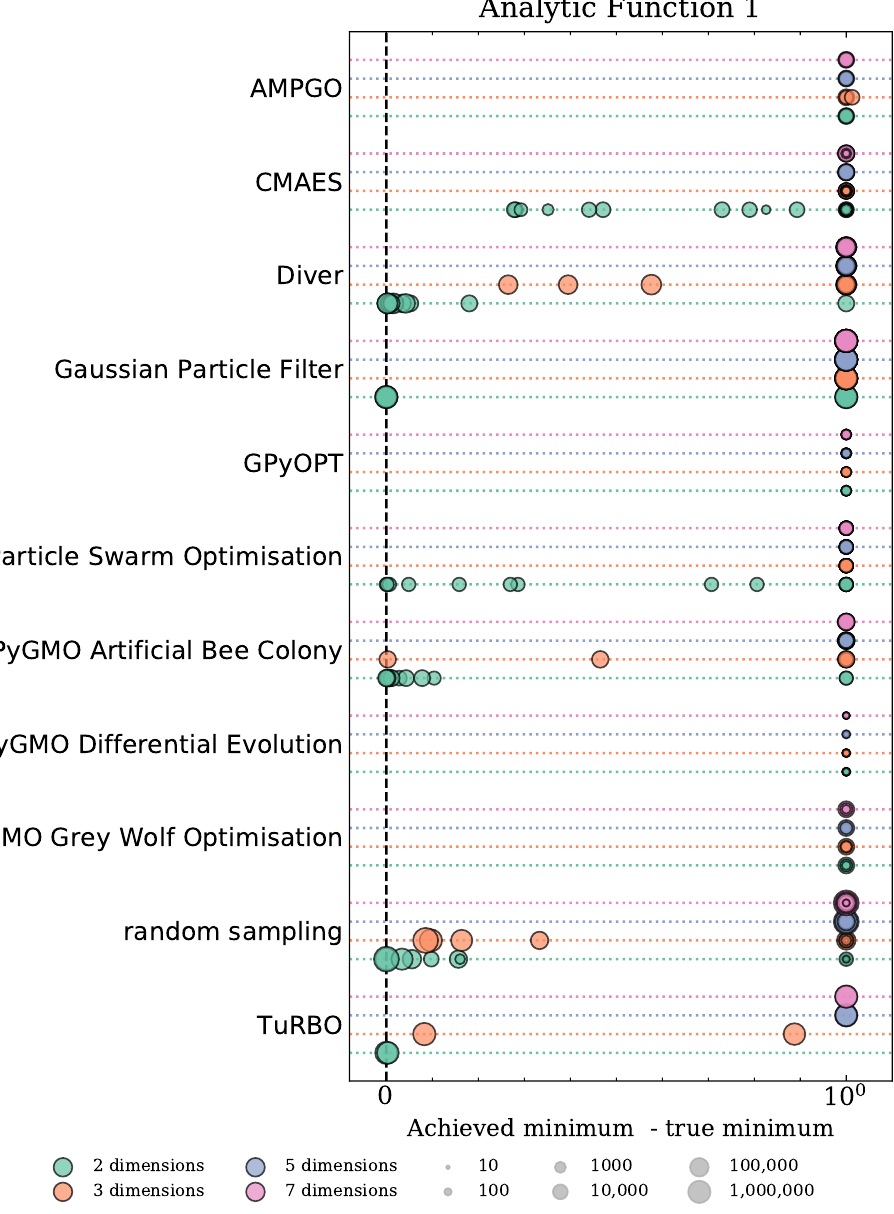
Figure 4. Results from different optimisation algorithms on the analytic function in equation (3.1). The results are shown as semi-opaque circles, of which the area increases logarithmically with the number of function evaluations needed to obtain that specific result. The four horizontal lines for each algorithm belong to the four explored dimensionalities, from top to bottom 7-dimensional (pink), 5-dimensional (purple), 3-dimensional (orange) and 2-dimensional (green). The horizontal axis shows the difference between the (known) log-likelihood at the global minimum and that at the found